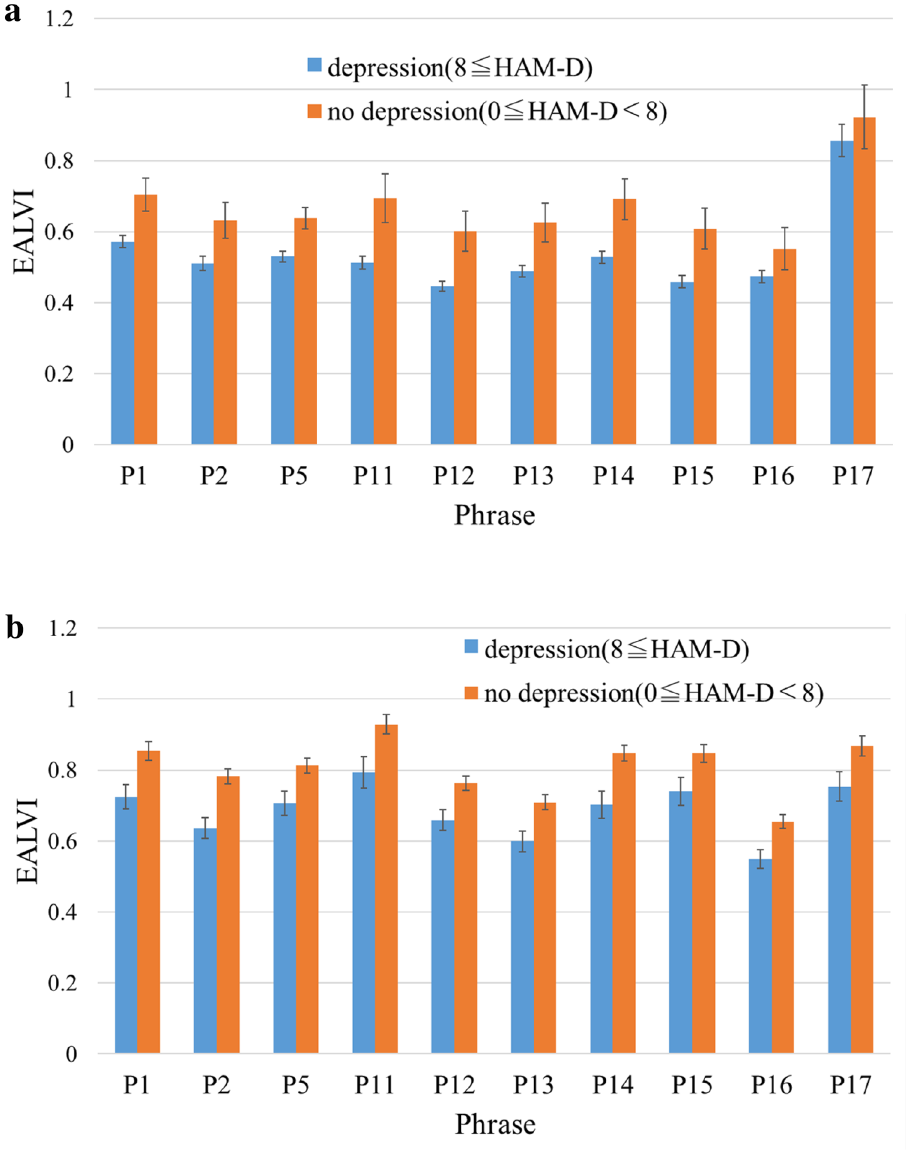
and “depression” groups for each phrase at the NDMC Hospital. Note : Error bars represent standard